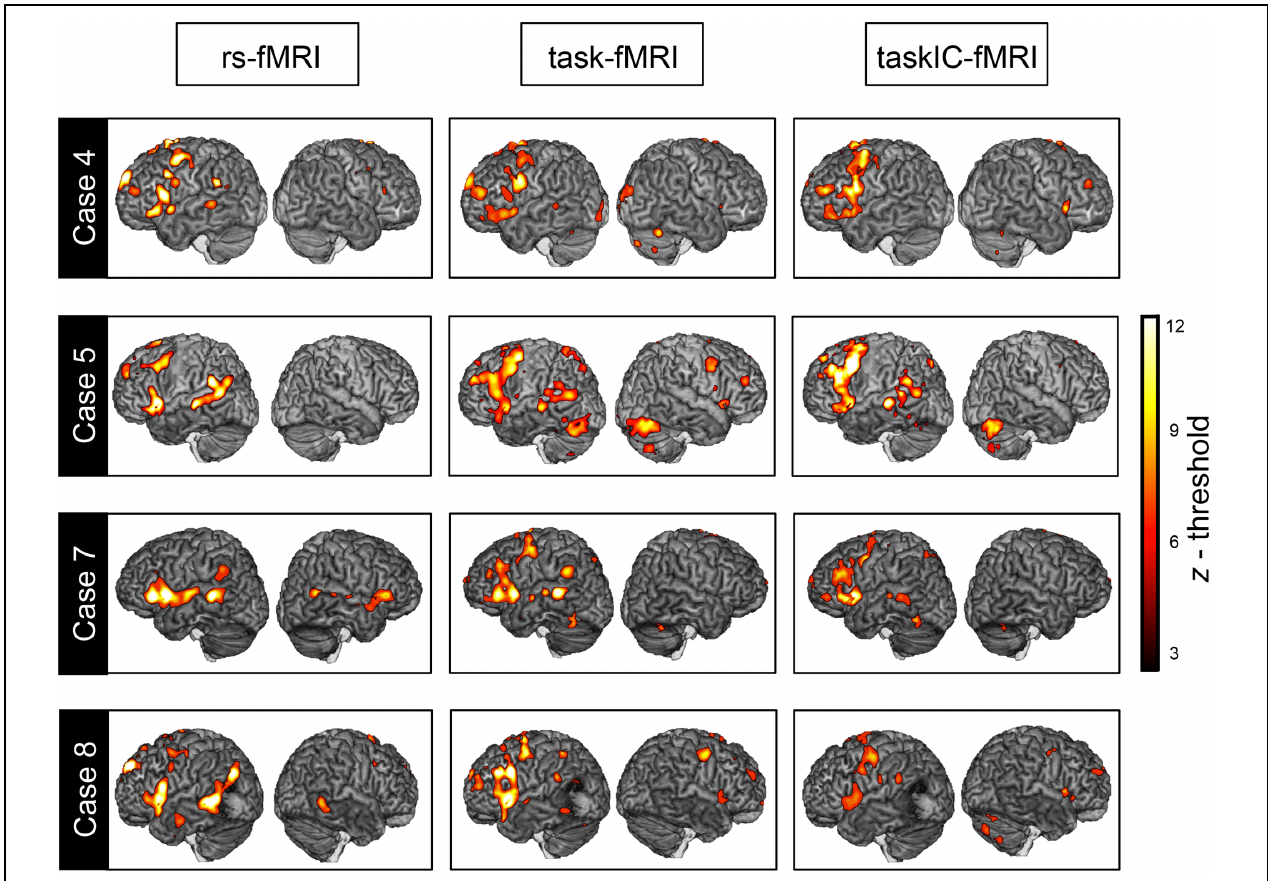
FIGURE 2 | Overlay between resting-state fMRI, task-fMRI and taskIC-fMRI. Language maps from representative subjects (Cases 4, 5, 7, and 8, see Table 1 ) with a Dice of 0.356, 0.297, 0.310, and 0.199 respectively, for task-fMRI and 0.340, 0.389, 0.315, and 0.298 respectively, for taskIC-fMRI. Threshold was set at z = 3 for illustration